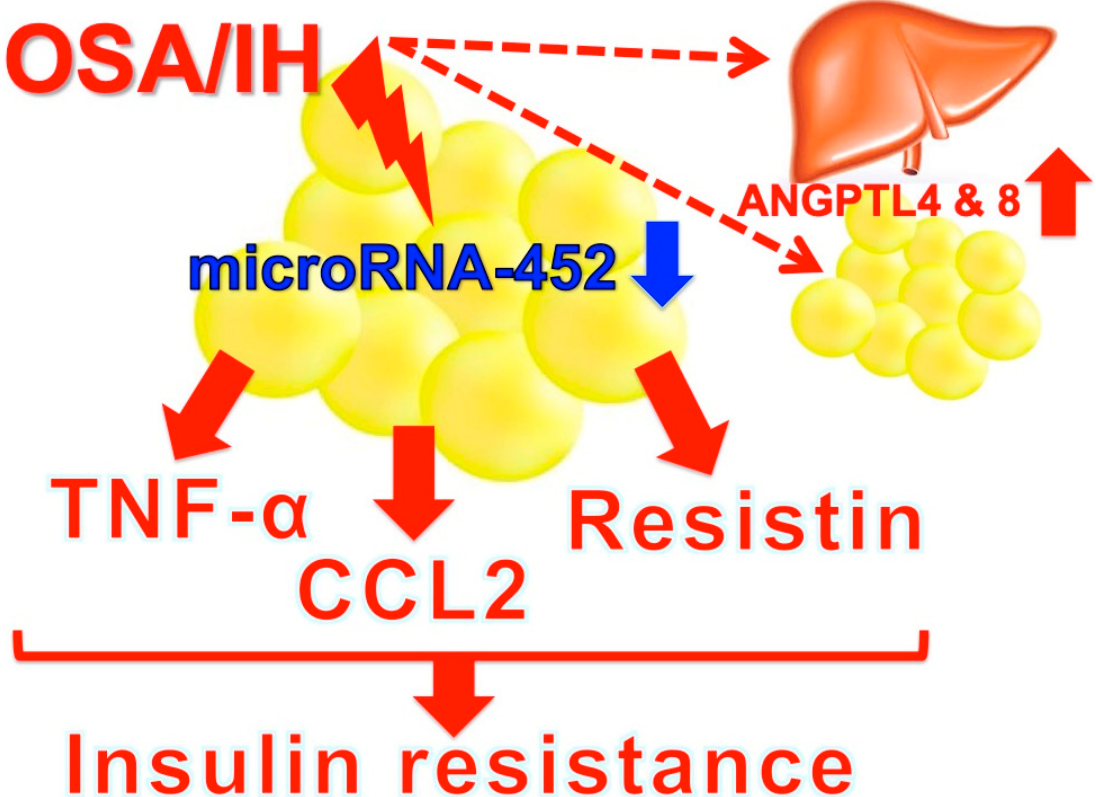
Figure 5. A possible mechanism of IH-induced insulin resistance. IH stress upregulates serum levels of ANGPTL4 and 8 [54] as well as the expression of adipokine(s) such as TNF- α , CCL2, and resistin via the downregulation of microRNA-452 to increase insulin resistance [55]. Secreted ANGPTL4, ANGPTL8, TNF- α , CCL2, and resistin all work together to lead to insulin resistance and / or type 2 diabetes in OSA patients.